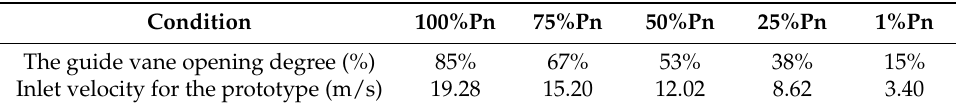
Table 2. Computation